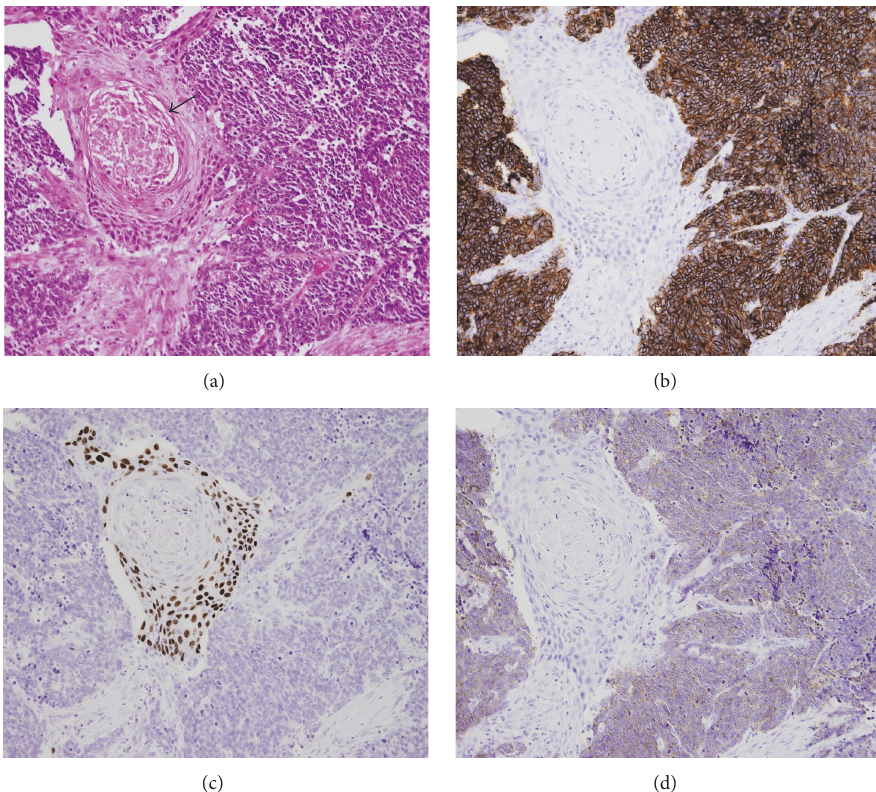
Figure 5: Histopathological and immunohistochemical features of the combined SmCC and SCC of the hypopharynx. (a) SmCC component coexisting with SCC component accompanying keratinization (arrow) (hematoxylin-eosin, original magnification 200x). (b) The CD56 reactivity in SmCC component is seen but is not seen in SCC component. (c) The p63 reactivity is seen in the nuclei of the cells of SCC but is not seen in SmCC component. (d) Synaptophysin shows positive cytoplasmic staining in SmCC